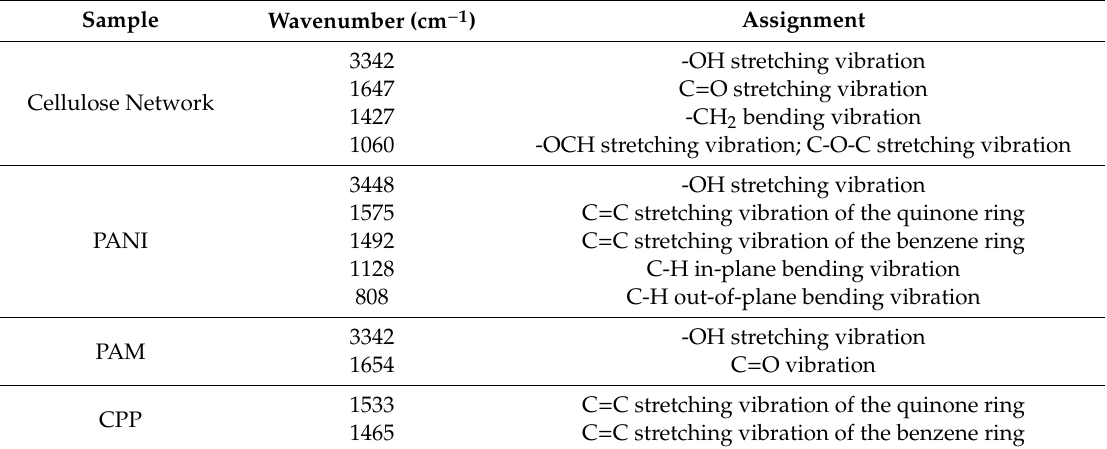
Table 1. Peak assignments in the FTIR spectra